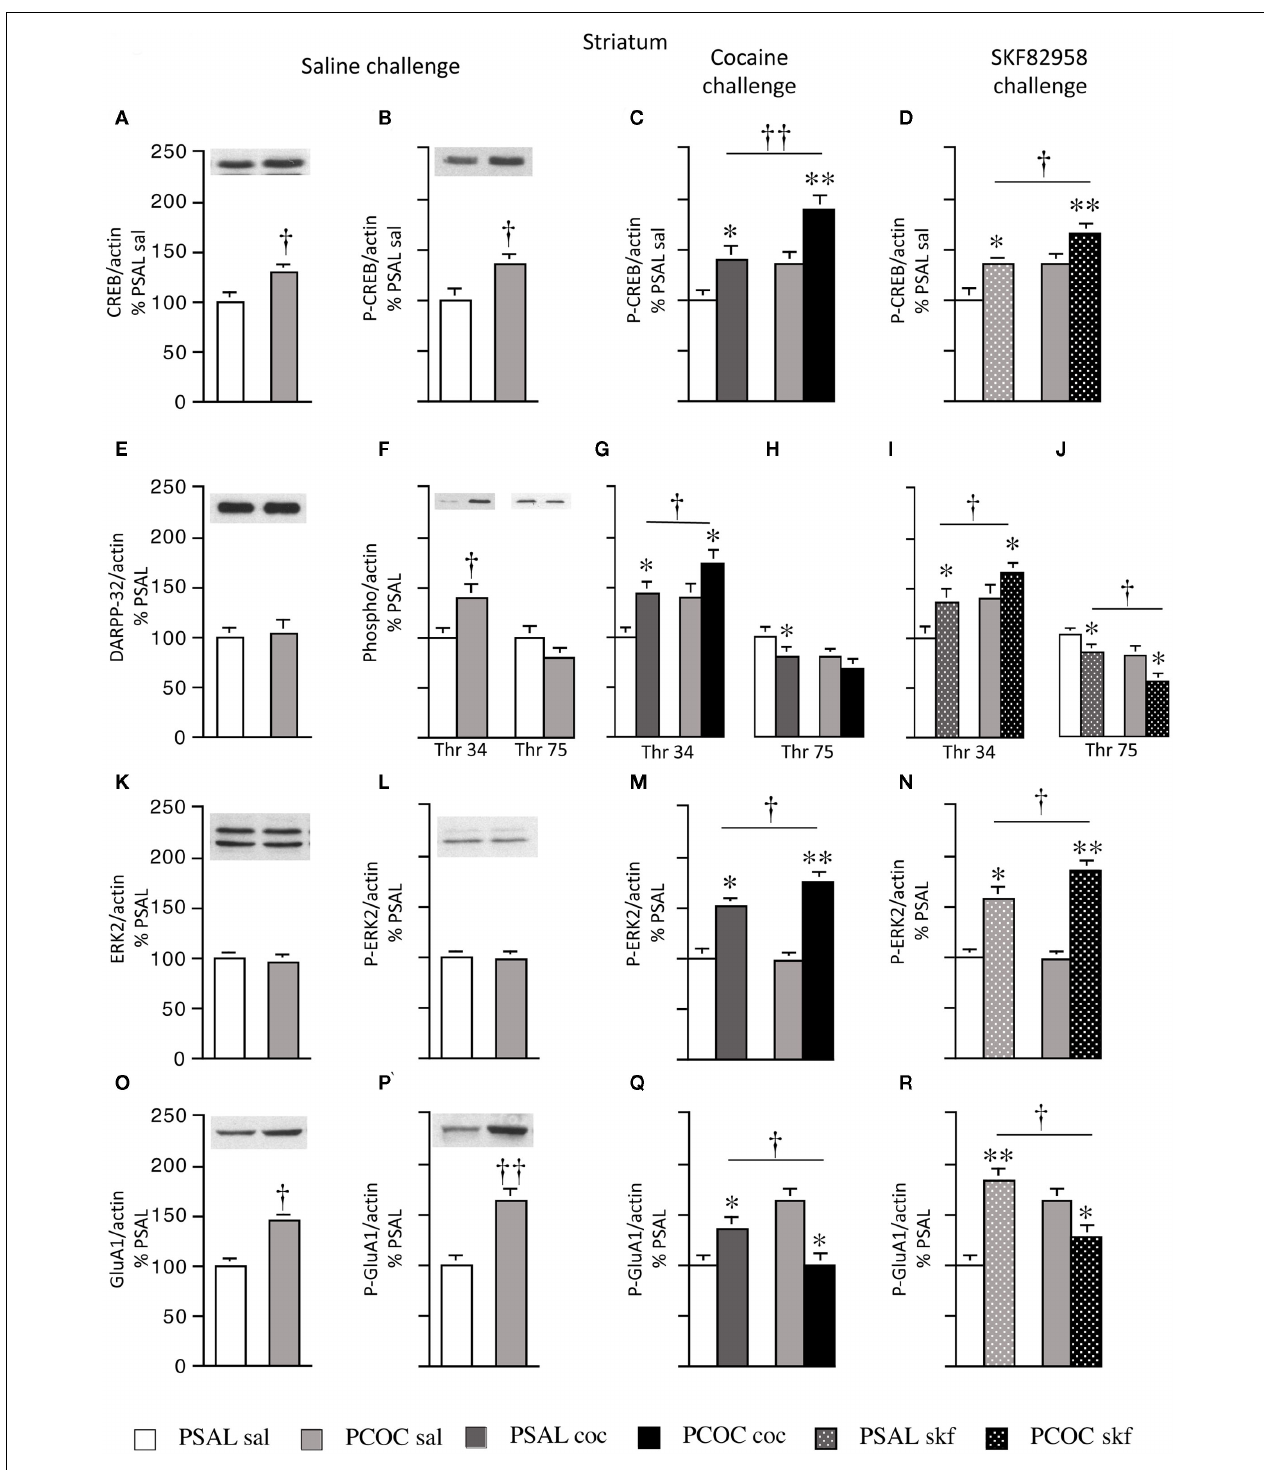
cocaine (PCOC) treated mice administered normal saline (sal), cocaine (15mg/kg; coc) or D1 agonist, SKF 82958 (1mg/kg; skf) as adults. Data are represented as percentage of PSAL mice treated with saline (PSAL sal). † p < 0.05, †† p < 0.01 PCOC pretreatment groups vs. PSAL pretreatment groups. * p < 0.05, ** p < 0.01, coc or skf treated mice vs. sal treated mice within the same prenatal treatment. Error bars represent ± SEM. N = 6–8